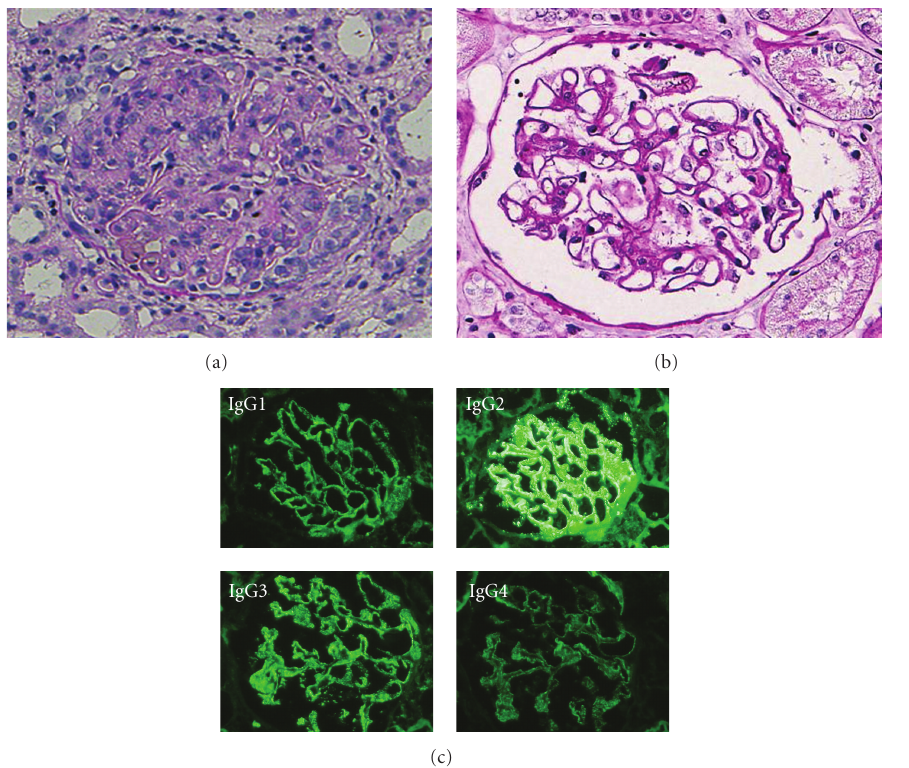
Figure 1: Two polar morphologic forms are representative of histological findings in lupus nephritis. (a) DPLN shows di ff use hypercellularity of endothelial cells and mesangial cells throughout the glomerulus. Peripheral capillary are thickened by subendothelial deposition of immune complex (x400, PAS staining). (b) On the other hand MLN shows generalized di ff use thickening of the peripheral capillary walls without prominent hypercellularity in the glomerulus (x400, PAS staining). (c) Glomerular IgG subclass deposits in a patient with MLN determined by immunofluorescence microscopy (x100). IgG subclass deposition was examined using FITC-conjugated mouse antihuman IgG subclass specific